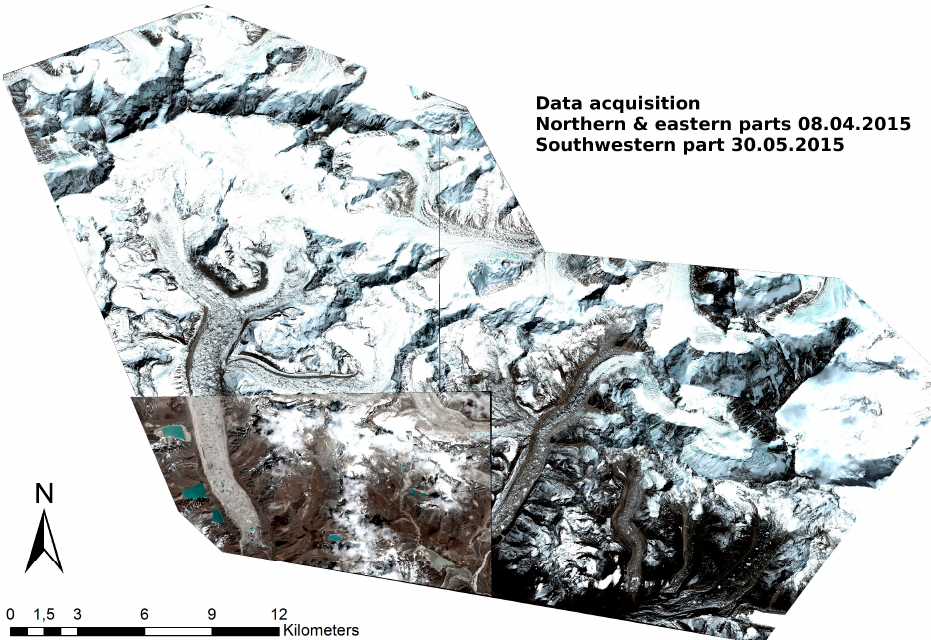
Figure 5. Example of the three spring 2015 Pléaides image tiles of the Khumbu Himal study area. In the northern and eastern part, snow was still present during acquisition, which influenced the respective digital elevation model (DEM) processing. UTM 45 N.